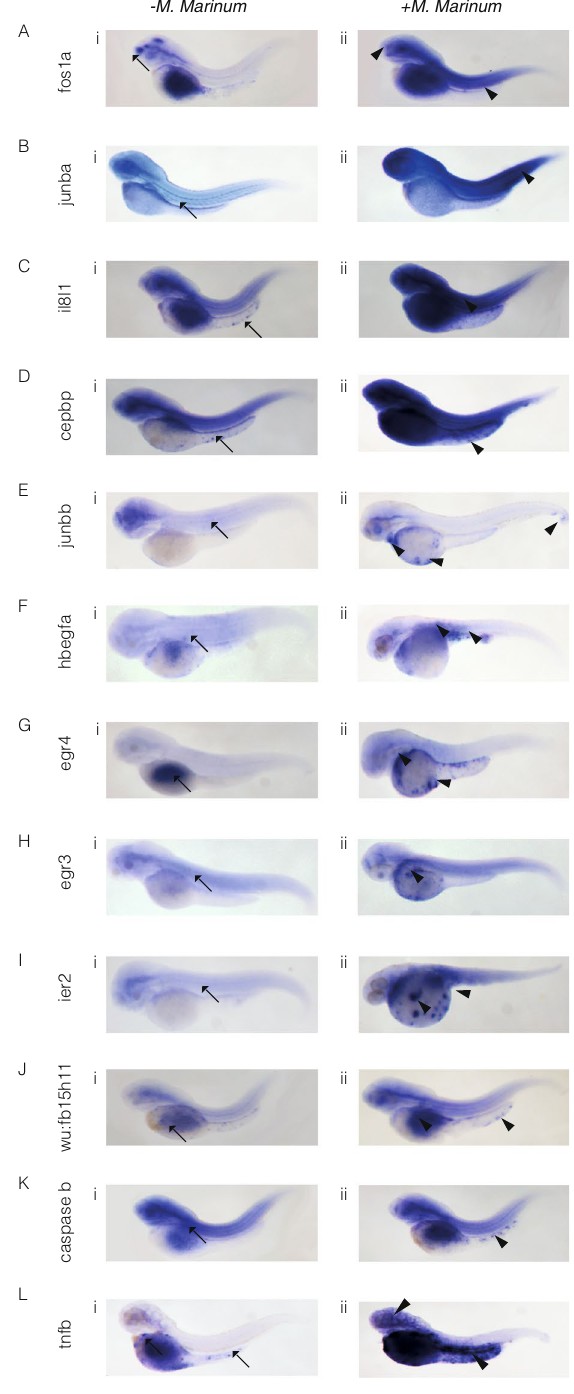
Figure 3. In situ hybridisation reveals spatial analysis of M . marinum -induced upregulated genes. Embryos were injected at the 32-512-cell stage with M . marinum . Expression patterns and gene transcript levels were analysed by in situ hybridisation using digoxigenin-labelled RNA probes, in uninjected controls ( A – Li ) and M . marinum -injected embryos ( A – Lii ). Control expression patterns are indicated by the black arrows with black arrowheads used to indicate altered expression patterns for fos1a ( A ), junba ( B ), il81a ( C ), cepbp ( D ), junbb ( E ), hbegfa ( F ), egr4 ( G ), egr3 ( H ), ier2 ( I ), wu:fb15h11 ( J ), caspase b ( K ) and tnfb ( L